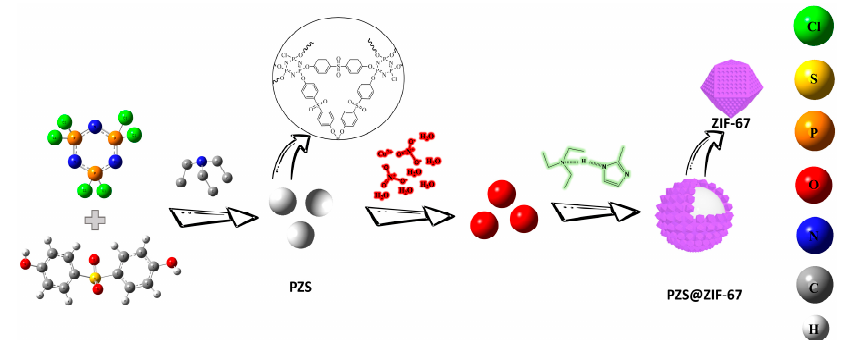
Figure 1. Synthetic diagram describing the preparation of PZS@ZIF-67.